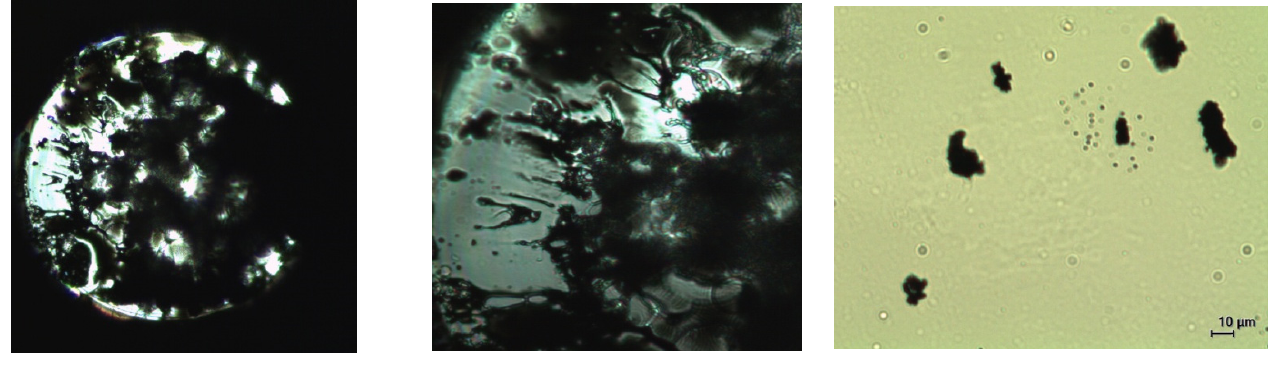
Figure 1. Microphotographs: ( a , b ) view of the tip face of the fiber with LRC, ( c ) graphite powder particles.